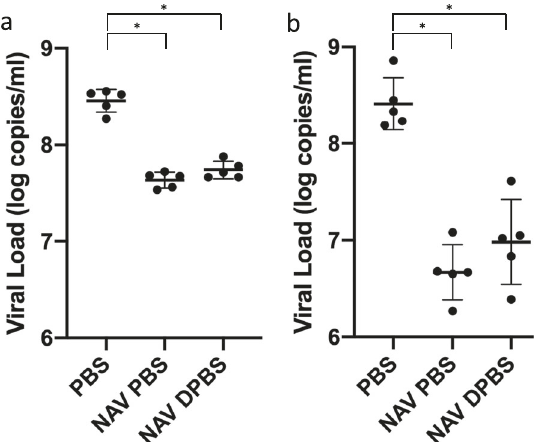
Fig. 7 NAV reduced pulmonary viral loads in mice challenged with A/California/04/2009 (H1N1). Mice were vaccinated with NAV in PBS, NAV in DPBS, and PBS control on days 0 and 28 and challenged with 10 5 TCID 50 A/Bethesda/MM2/2009 (H1N1) on day 56. Pulmonary viral loads on day 3 ( a ) and day 6 ( b ) ( n = 5 at each time point) after challenge were assessed by PCR. Points represent viral loads of individual mice and error bars represent means with standard deviations. ANOVA and post-hoc Tukey test were performed where * p <